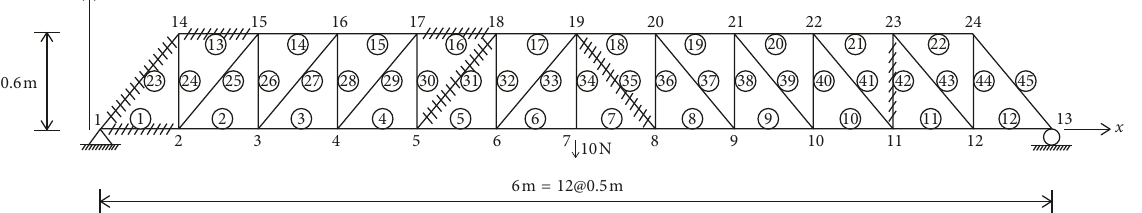
Figure 10: Truss members to represent high stress variation rates.